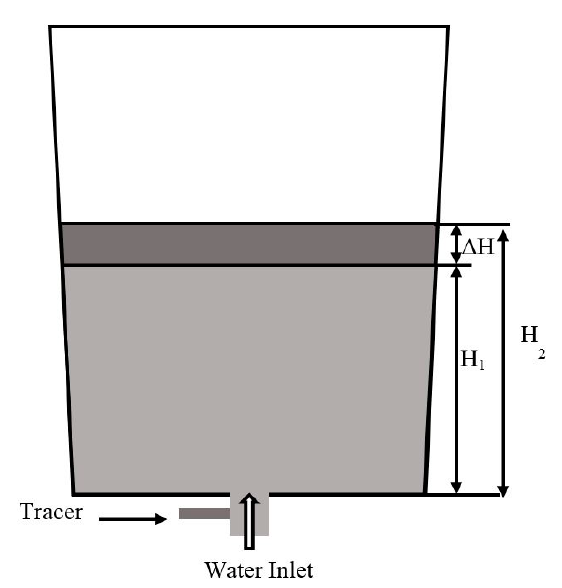
Figure 3. Schematic of the investigating method.